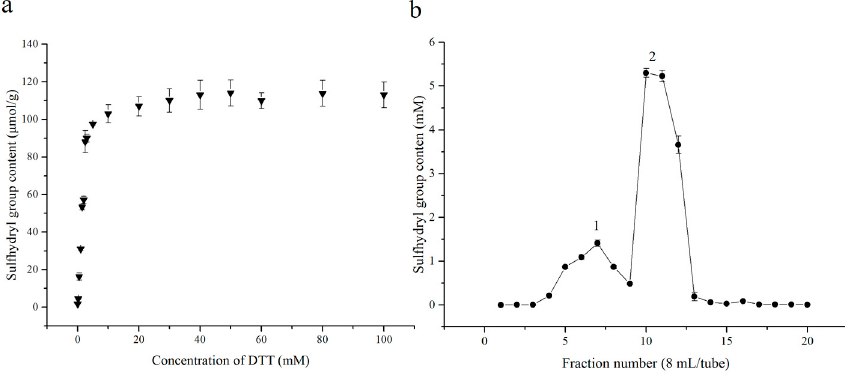
Figure 1. ( a ) Effect of concentration of DTT on the sulfhydryl group content of SGHs; ( b ) Sephadex LH-20 profile of reduced SGHs.